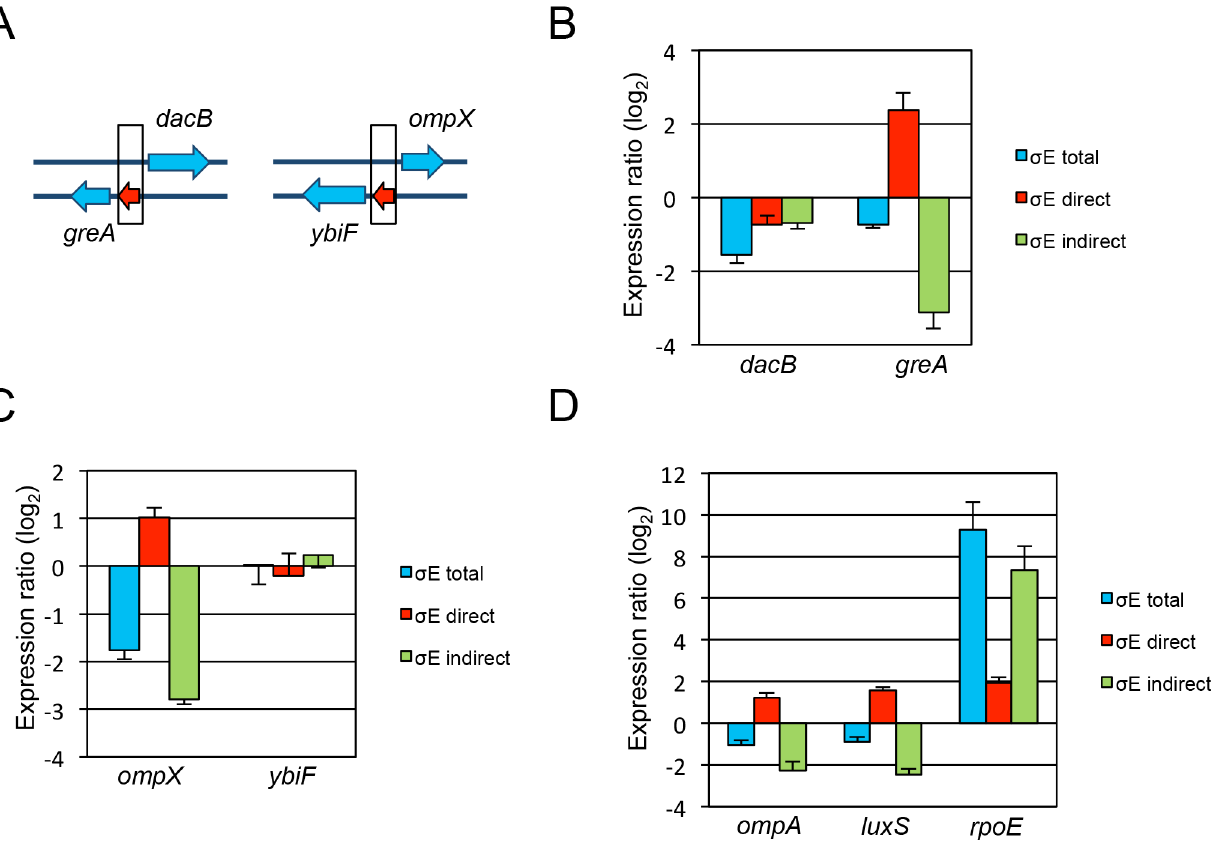
Fig 6. Dissection of the direct versus indirect regulatory effects of σ E on gene expression. The total regulatory effect of σ E on gene expression ( σ E total) was calculated by comparing the expression ratio of certain gene in WT versus Δ rpoE background (log 2 WT/ Δ rpoE ). The effect of σ E as a result of direct binding to the 5 ’ element of a particular gene ( σ E direct) was calculated by comparing the expression ratio of the gene in WT versus its σ E consensus sequence substituted mutant. The indirect regulatory effect of σ E ( σ E indirect) was calculated by comparing the expression ratio of the gene in Δ rpoE versus its σ E consensus sequence substituted mutant. (A) Diagram of σ E consensus sequence (red) in relation to bi-directional flanking genes ( greA versus dacB ; ybiF versus ompX ). The black rectangle represents σ E – binding site identified by ChIP-seq. (B) σ E -binding in between dacB and greA genes directly activated greA instead of dacB . (C) σ E -binding in between ompX and ybiF genes directly activated ompX instead of ybiF . (D) σ E directly activated ompA , luxS , and rpoE